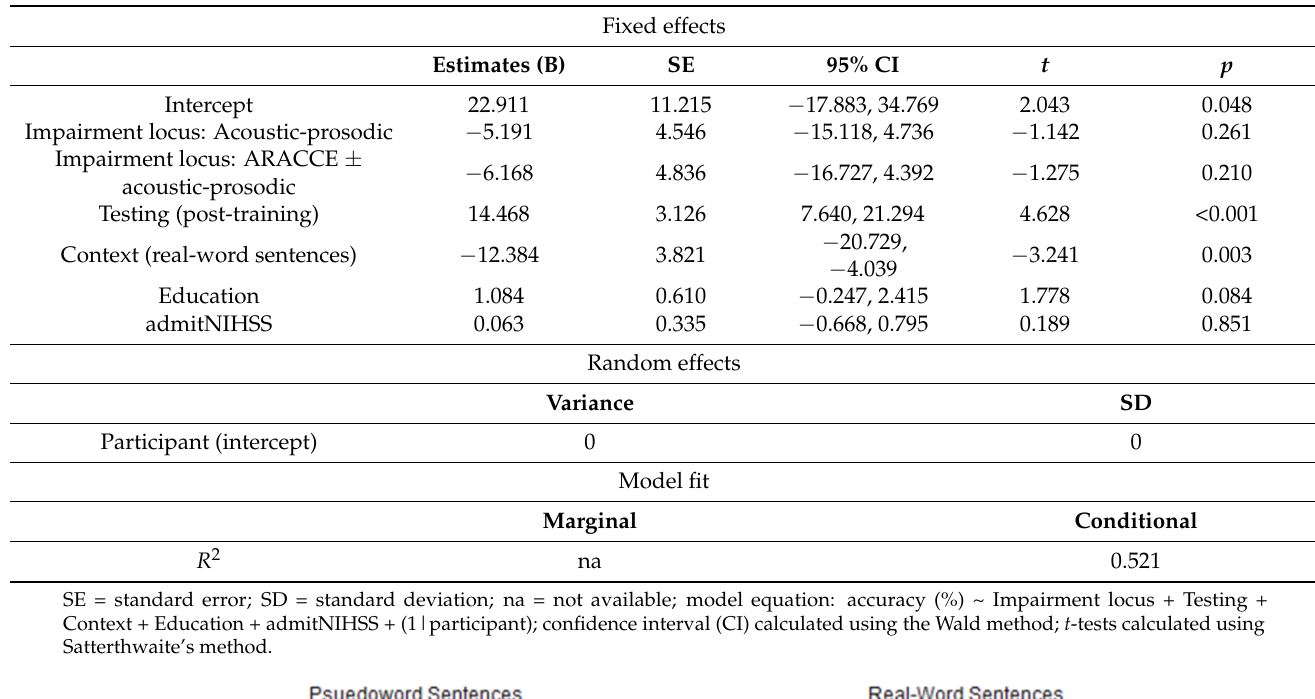
Table 3. Summary of selected full linear mixed effects model.